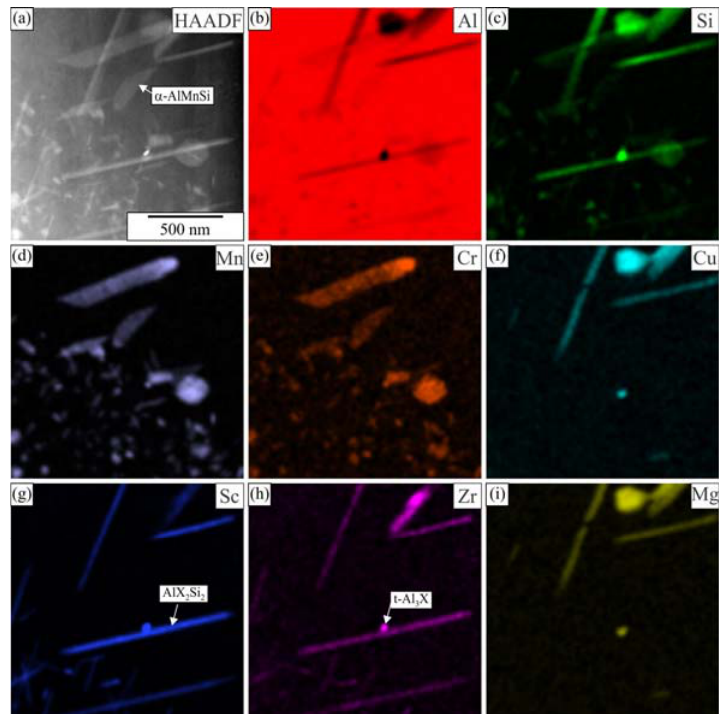
Figure 13. Distribution of the elements within the matrix of the alloy 6086-Sc after homogenization and holding for 5 h at 400 °C ( a ) HAADF micrograph, EDS mapping of selected elements ( b ) Al, ( c ) Si, ( d ) Mn, ( e ) Cr, ( f ) Cu, ( g ) Sc, ( h ) Zr, and ( i ) Mg.